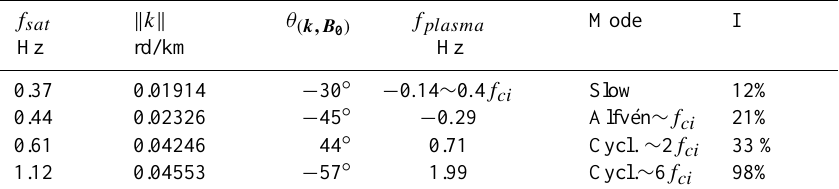
Table 4. Using the k-filtering technique other waves with lower intensities are identified for the four studied frequencies. Only the first secondary maxima are given here. In Column “I” are given their intensities compared to that of the dominant wave for the corresponding frequency. f plasma is the relative frequency in the plasma frame, f ci =0.33Hz is the proton gyrofrequency.